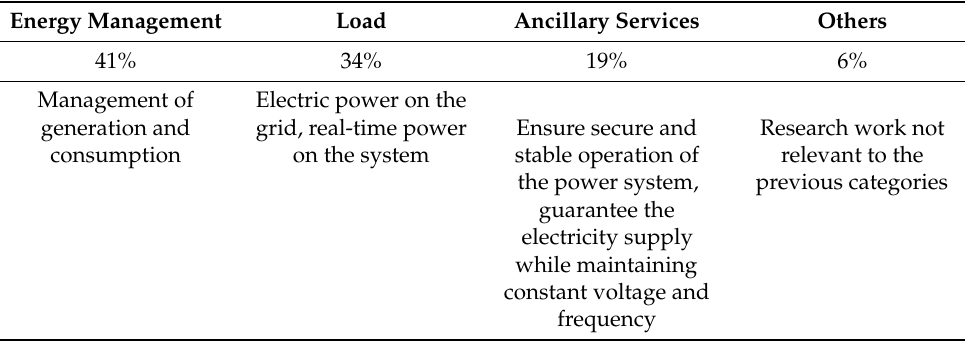
Table 1. Keyword architecture within the selected demand response